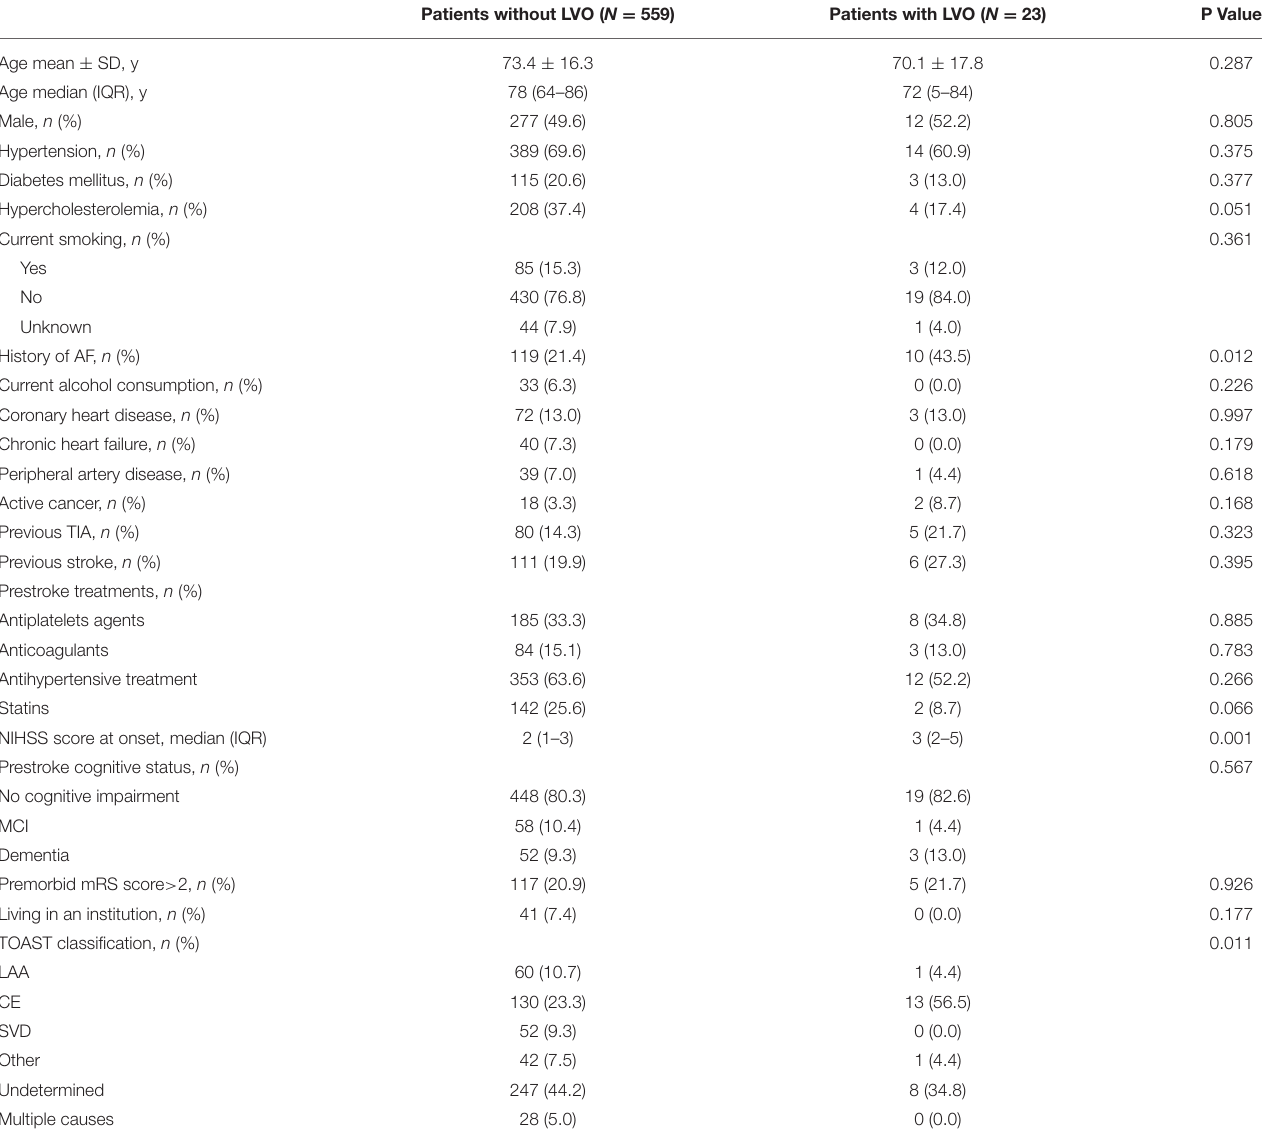
TABLE 2 | Characteristics of minor ischemic stroke patients presenting with ( n = 23) or without large vessel occlusion (LVO; n = 557). Patients without LVO ( N =